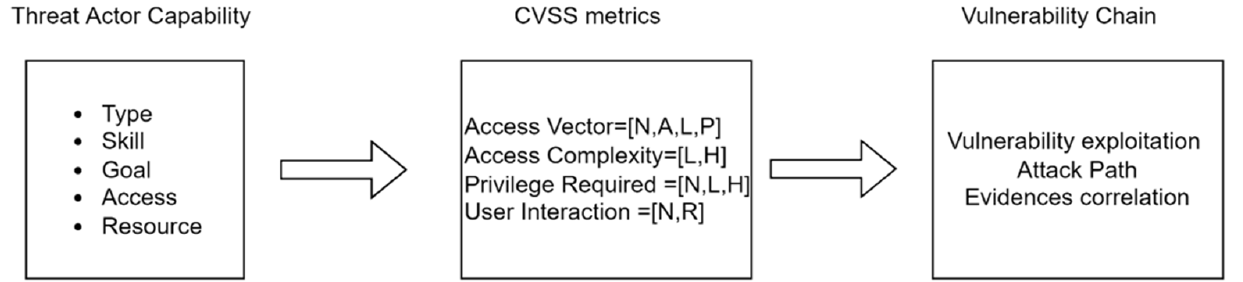
Figure 1. Threat actor capability linking with vulnerability chain.